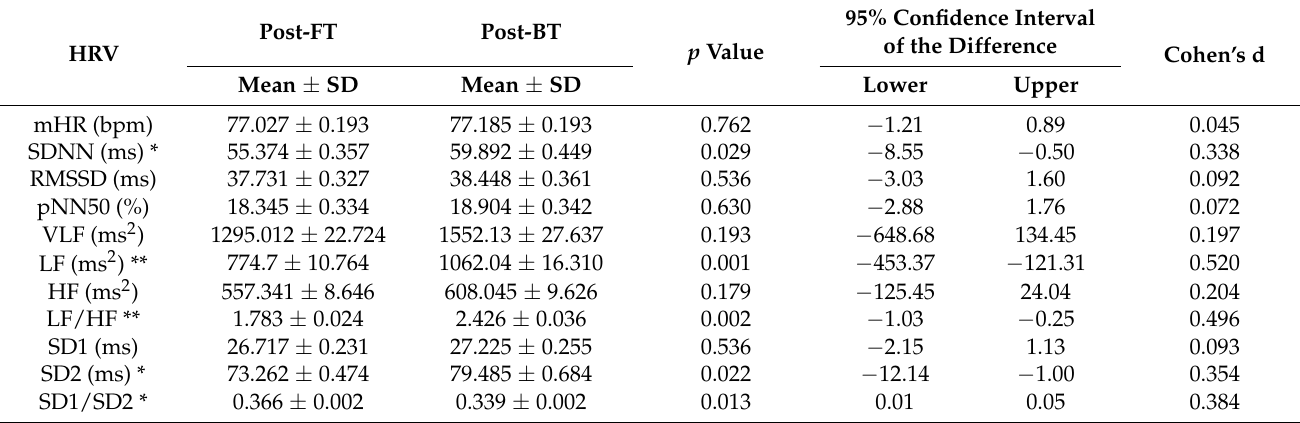
Table 1. Within-individual comparison of the heart rate